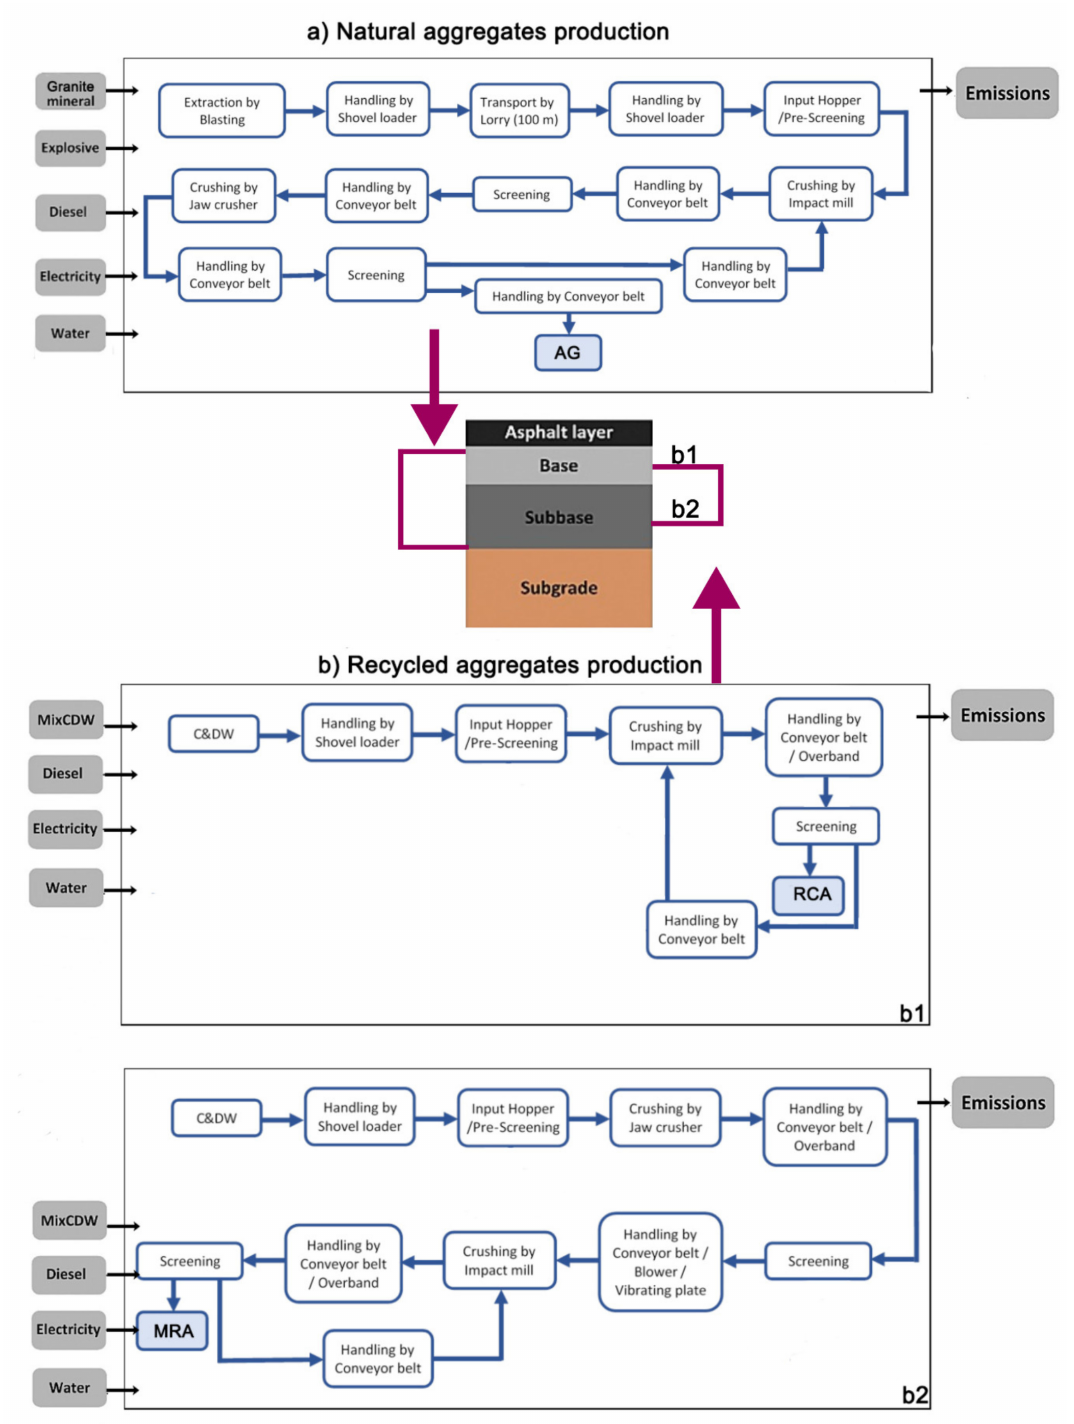
Figure 13. System boundaries for production of artificial gravel (AG), production of concrete and mix CDW recycled aggregate (RCA) and